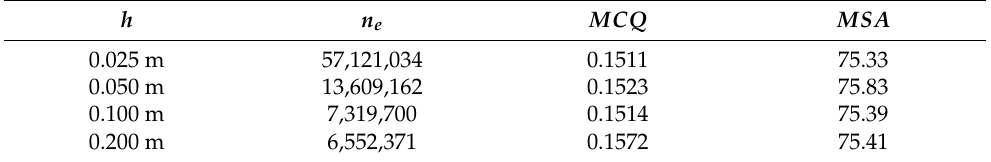
Table 4. Metrics computed for the mesh tests, where h is the average mesh cell size, n e is the number of mesh cells, MCQ is the minimum cell quality, and MSA is the maximum skewness angle. h n e